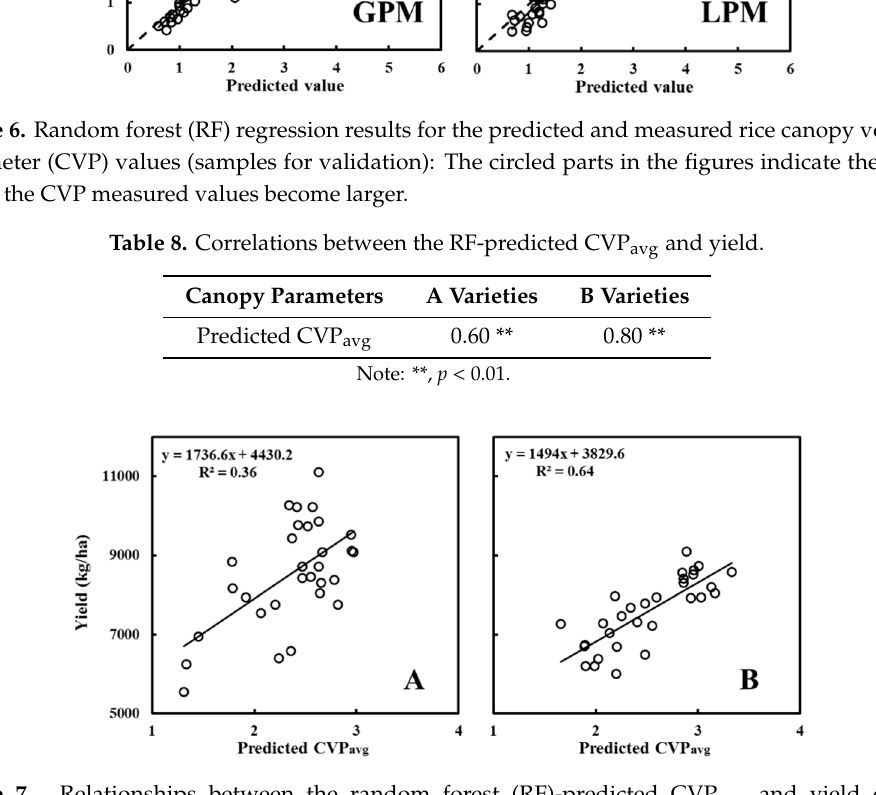
Figure 7. Relationships between the random forest (RF)-predicted CVP avg and yield of the A and B varieties.